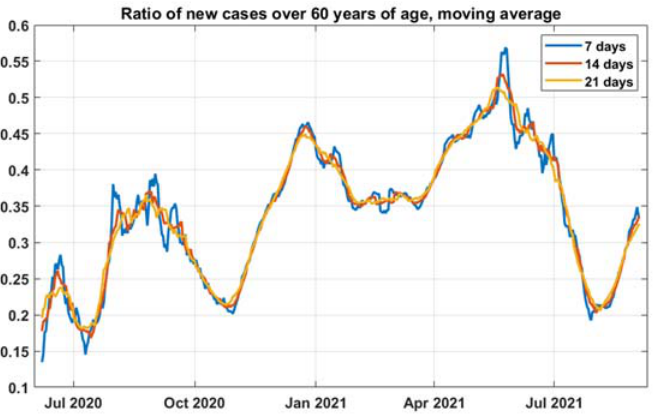
Figure 3. Comparison of 7, 14, and 21-days moving averages for r 60+ .